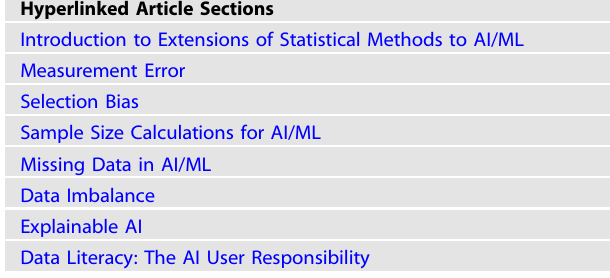
Table 1. The Table of Contents is hyperlinked to ease navigation to sections within the